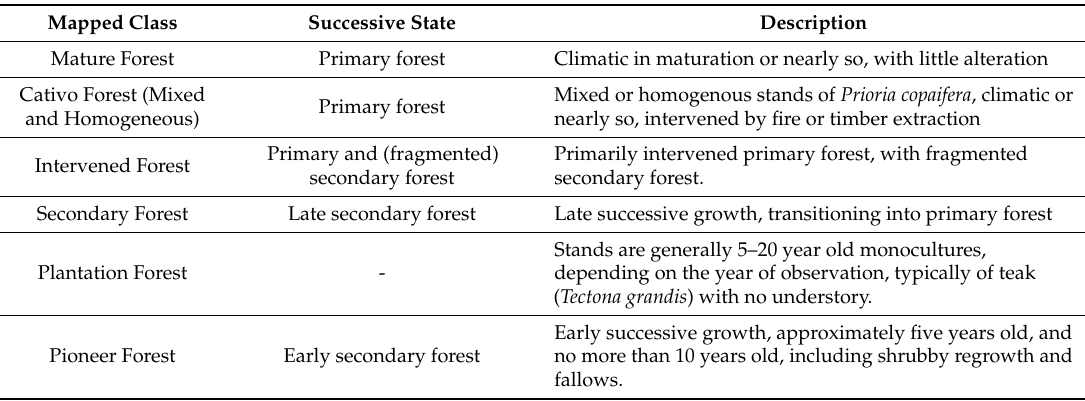
Table 2. Mapped forest-cover classes.